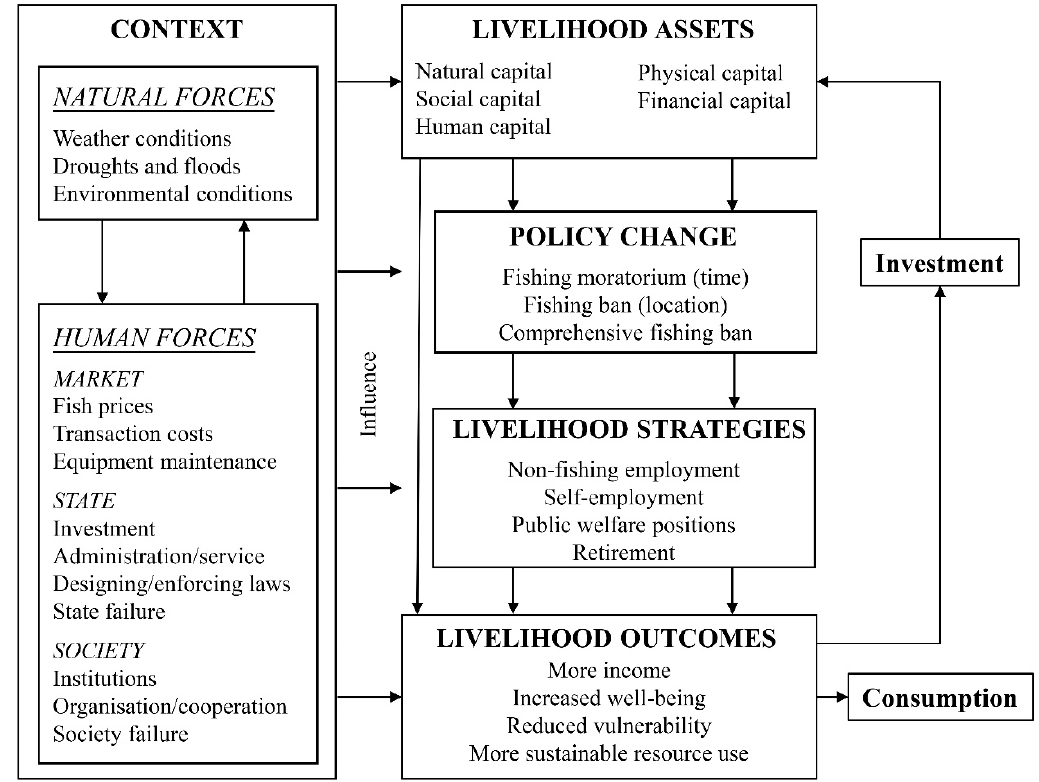
Figure 1. Fishermen’s livelihood strategy framework (adapted from [40,43–46]).